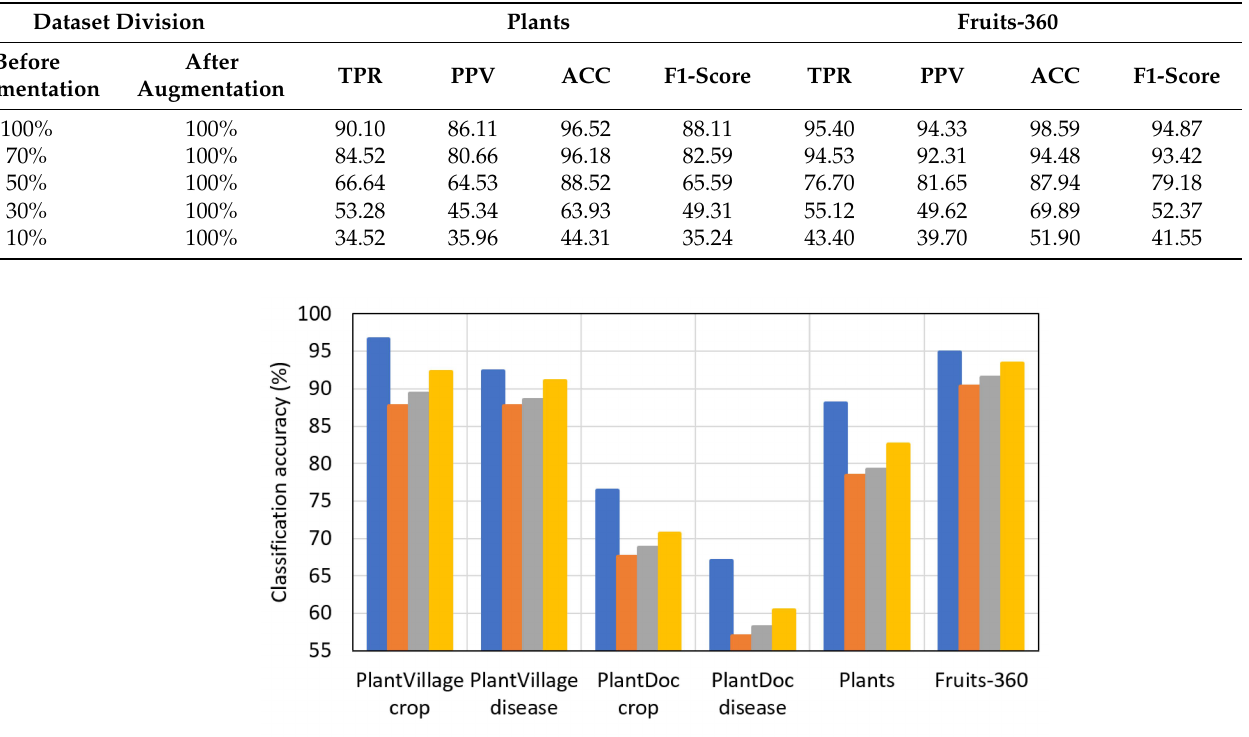
Table 27. Comparison of accuracies achieved by the proposed PI-CNN in the original and PI-GAN- augmented datasets. The accuracies were achieved in the Plants and Fruits-360 datasets (unit: %).